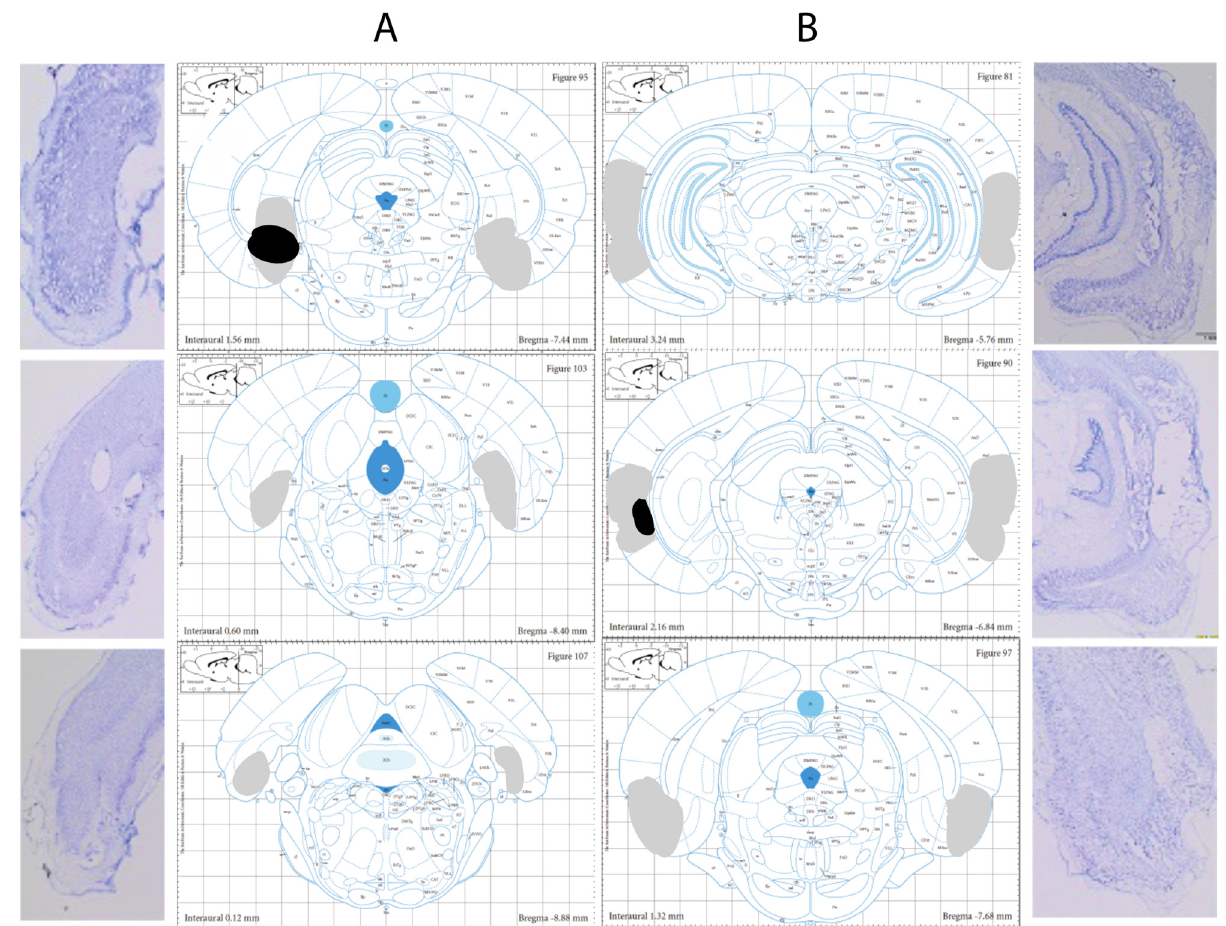
Figure 2. Atlas plates demonstrating the minimal (black) and maximal (grey) lesion extents for MEC ( A ) and LEC ( B ) lesions, along with representative photomicrographs (Reprinted with permission from Ref. [30]. Copyright 1998 Academic Press: Cambridge) .